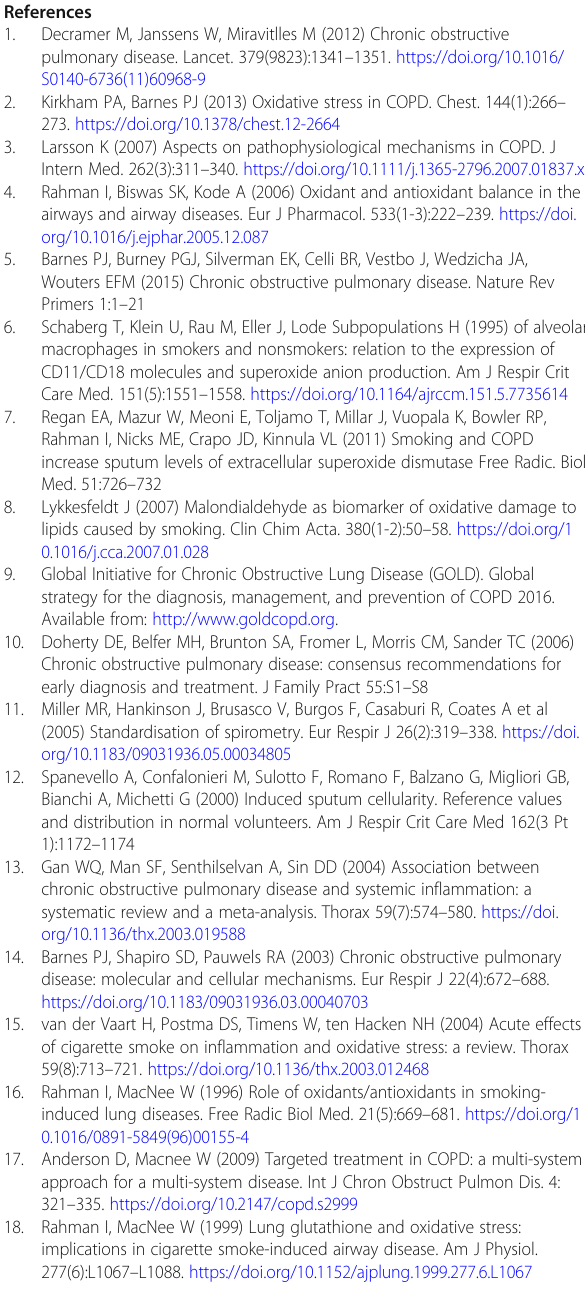
Spearman ’ s correlation *Significance level at P value